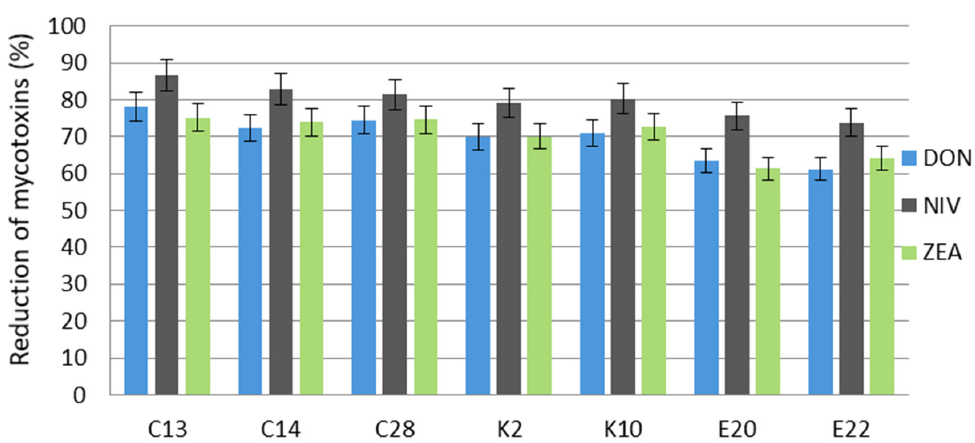
Figure 2. Reduction of deoxynivalenol, nivalenol, and zearalenone produced by F. graminearum in wheat grain after a 14-day incubation with the test yeasts. C13, C14, C28, K2, K10, E20, E22—code numbers of the yeast species acc. to Table 2. Error bar represents the standard error. F. poae, in the control sample, produced similar mean amounts of DON and NIV in wheat grain at 924.6 µg/kg and 971.3 µg/kg, respectively, and significantly lower amounts of ZEA at 106.0 µg/kg (Table 3). As in the case of F. culmorum , in some variants of the